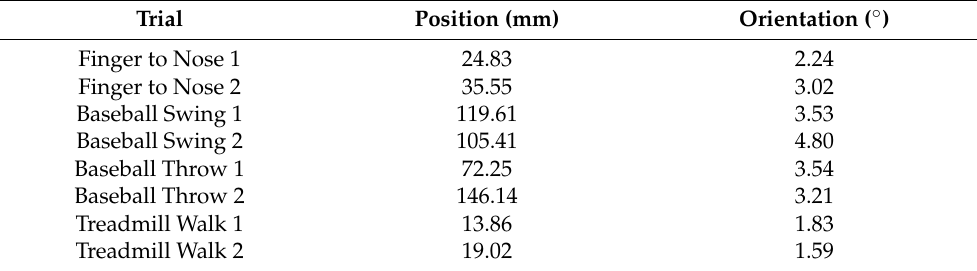
Table 2. Position (Euclidan distance) and Orientation errors as compared to the optical motion capture